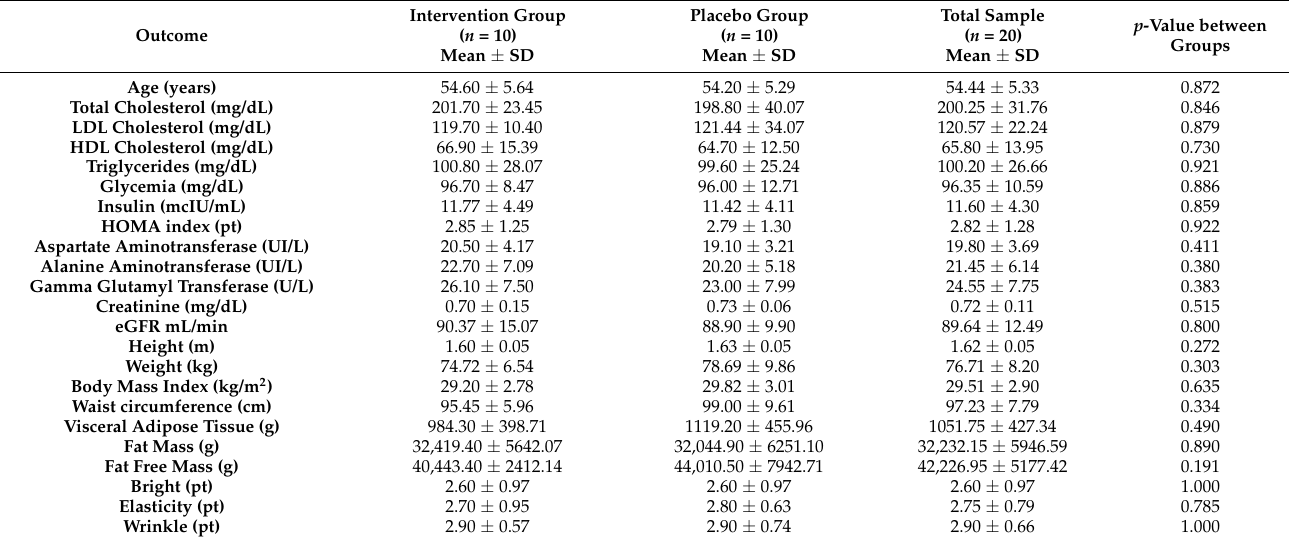
Abbreviations—eGFR: Glomerular Filtration Rate, HDL: High Density Lipoprotein, LDL: Low Density Lipoprotein, SD: standard